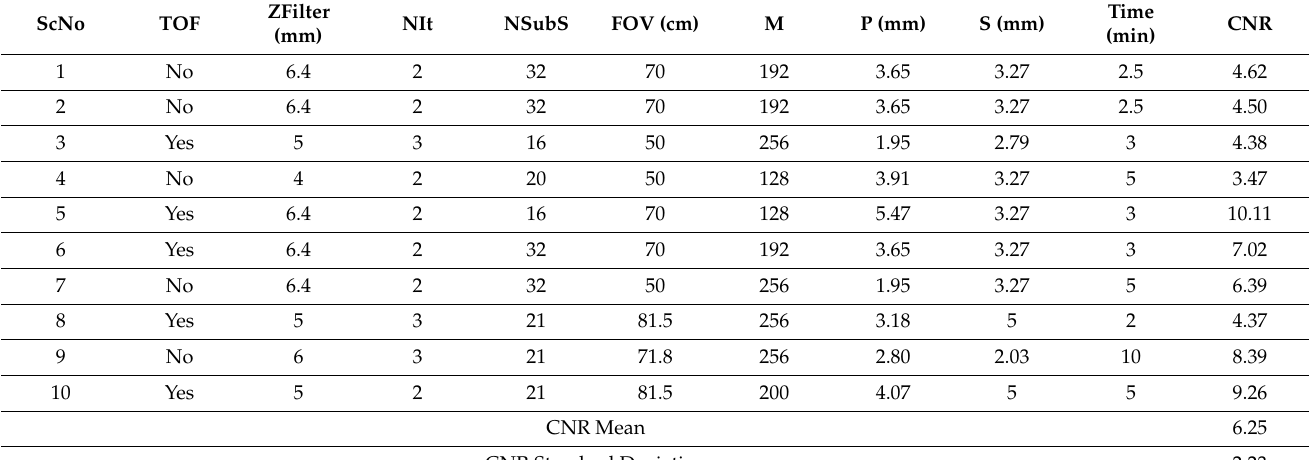
Table 2. Reconstruction parameters and contrast-to-noise ratios for the standard dataset (10 PET images). ScNo = scanner number from Table 1. TOF = time of flight acquisition, ZFilter = post- reconstruction filter, NIt = number of iterations, NSubS = number of subsets, FOV = field of view, M = matrix size, P = pixel spacing (pixel size), S = slice thickness, Time = acquisition time (per